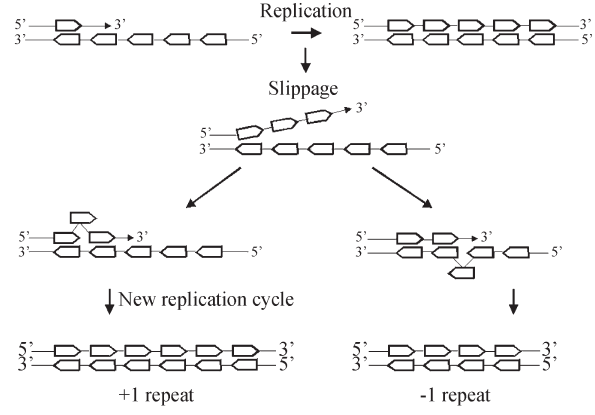
Figure 2 - Slippage during DNA replication. Assume that in the original DNA molecule there were 5 repeats of the motif, symbolized by a box. Slippage leads to the formation of new alleles with 6 and 4 repeats, de- pending on the strand containing the polymerase error (Modified from Goldsteind and Schlotterer,